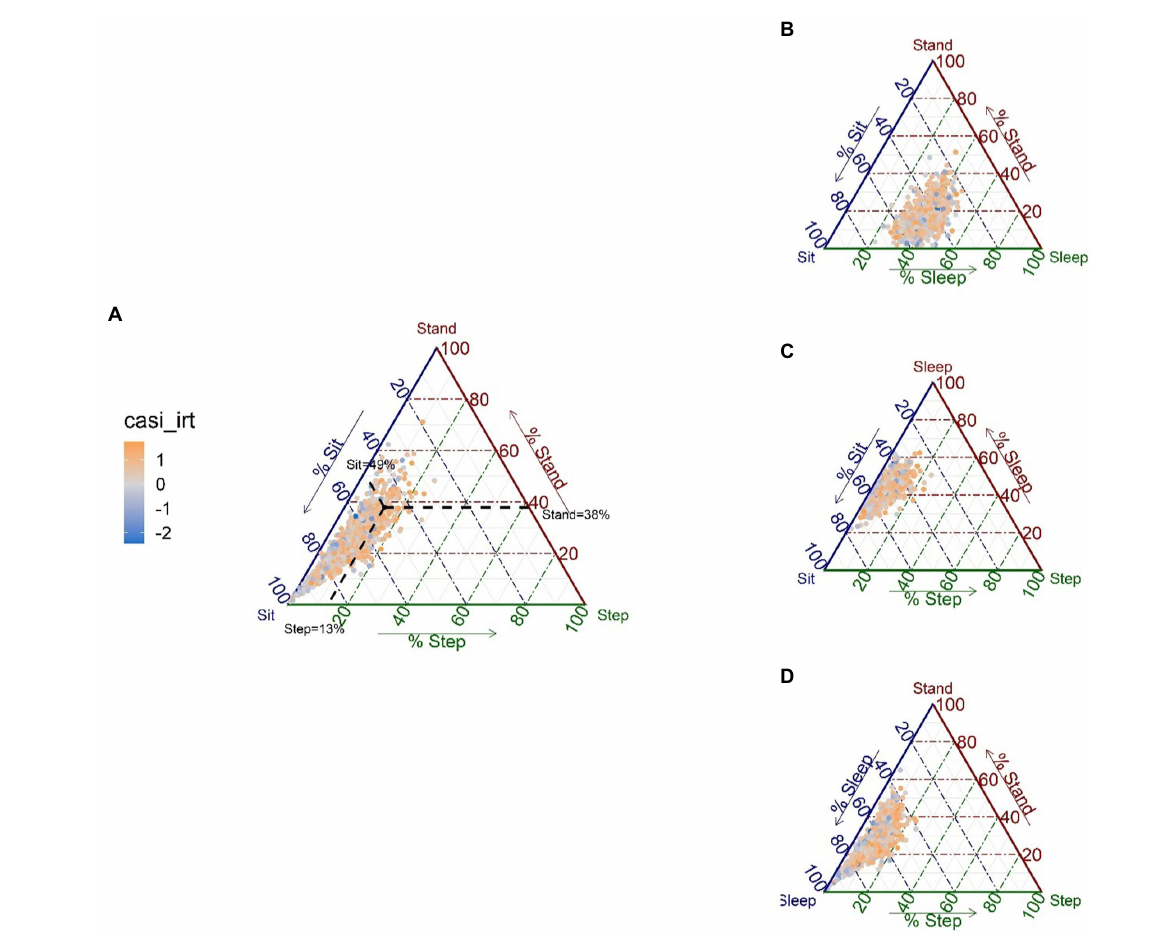
FIGURE 1 Ternary diagrams for each of the possible sub-compositions of 3 activities, with the CASI-IRT score represented with a color gradient scale (negative scores in blue, positive scores in orange) ( N = 1,034). For each ternary diagram, the vertices represent three behaviors of the composition, and each side of the triangle is an axis representing values for each behavior, ranging from 0 to 100%; in (A) , sleep is omitted; in (B) , step is omitted; in (C) , stand is omitted; in (D) sit is omitted. Points that lie close to a vertex have high percentages of the behavior represented by that vertex, whereas points lying in the center of the triangle have equal percentages of all three behaviors. For example, for the solid black point on the diagram (A) , we can read the percentage of each behavior for that point by drawing a line to each axis as illustrated by the black dashed lines (sit = 49%, stand = 38%, and step =